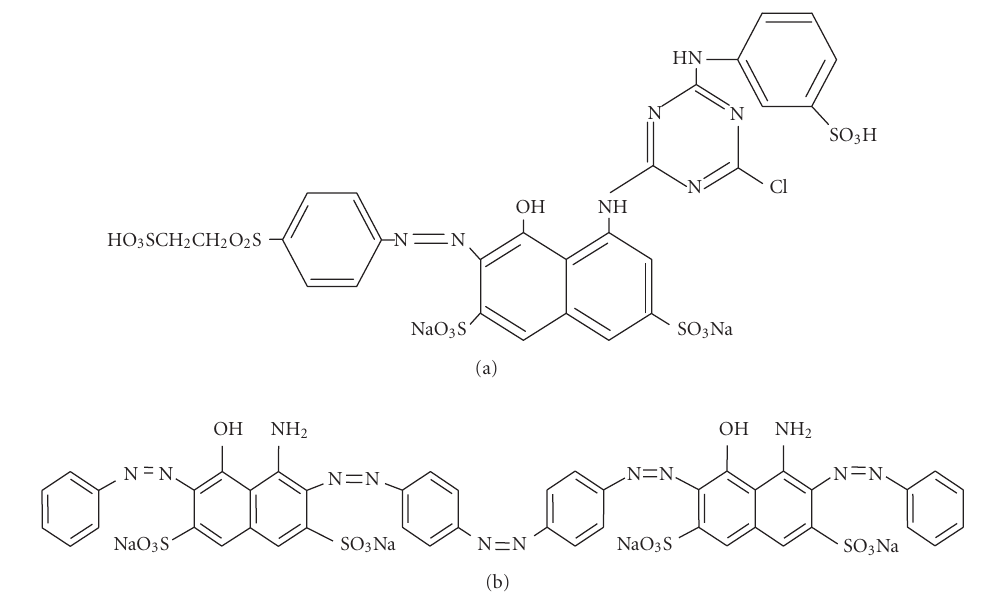
Figure 1: The chemical structure of (a) Reactive Red 198 and (b) Direct Green